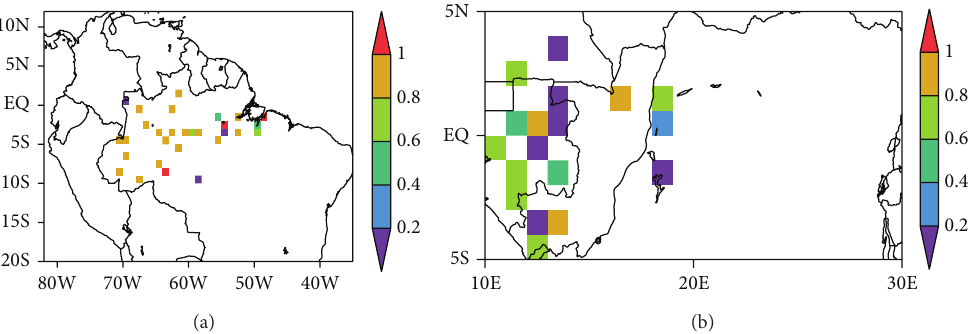
Figure 1: The temporal coverage of rain gauges within each 1 ∘ × 1 ∘ pixel with the results represented as a fraction of the total time duration from 1996 to 2006 over (a) the Amazon rainforests and (b) the Congo